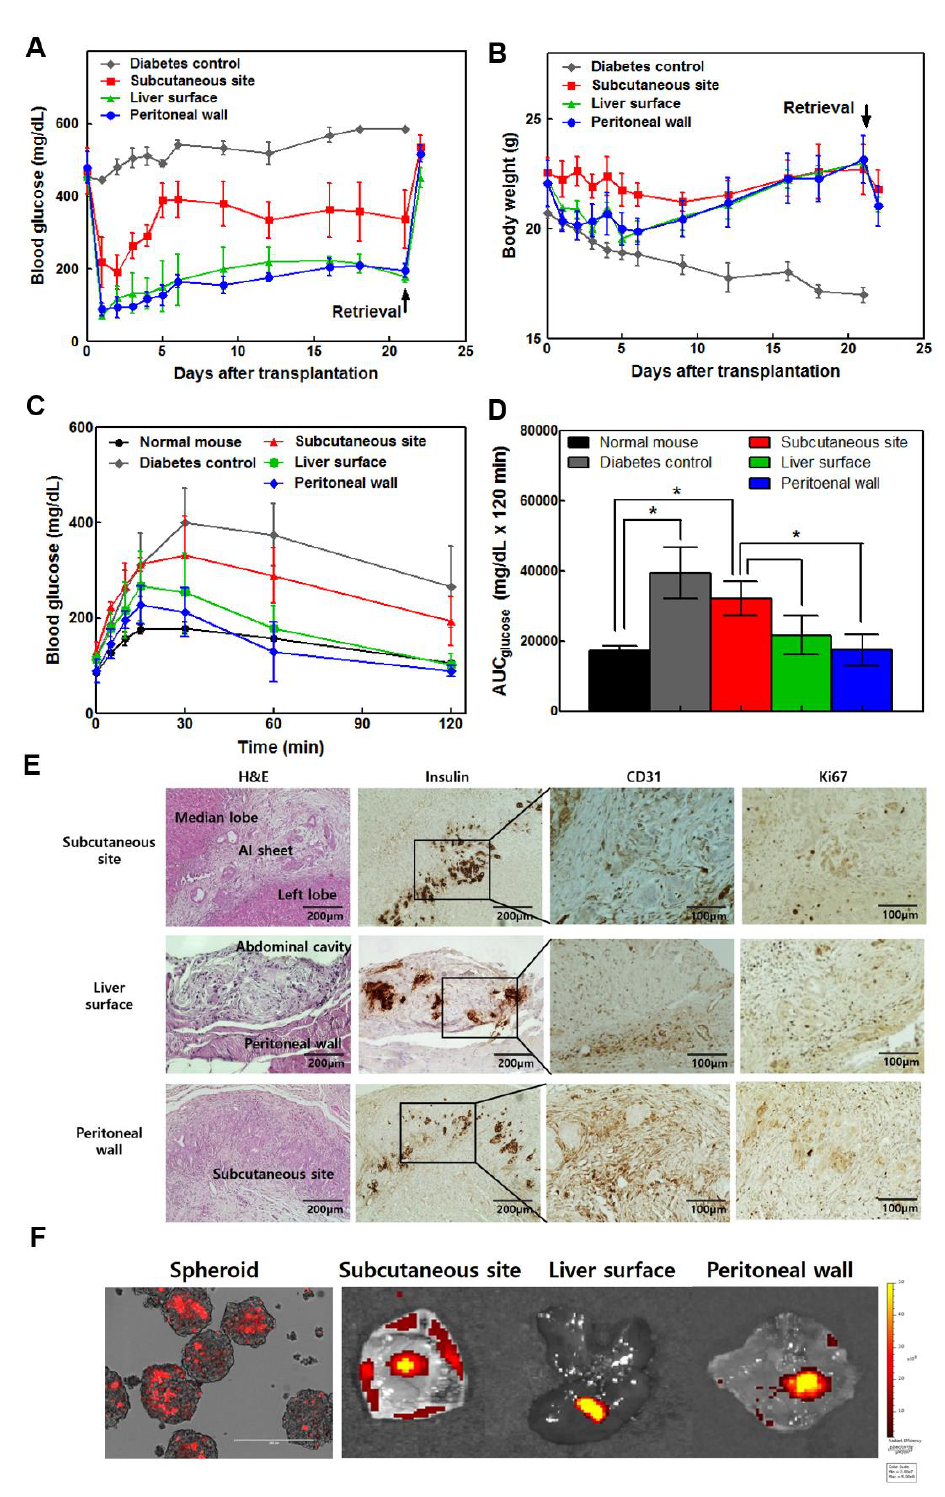
Figure 4. The liver and peritoneal surface were more effective sites for cell sheet transplantation among subcutaneous, liver surface, and peritoneal wall sites using human islets (5000 IEQ) and ADSC multi-layered sheets in diabetic nude mice ( n = 4). ( A ) Transplantation of AI sheets onto the three sites was performed successfully. The liver and peritoneal surface were more effective for controlling blood glucose levels. ( B ) The liver surface and peritoneal wall groups showed increased body weight. The subcutaneous group-maintained body weight, but diabetic control mice dramatically decreased in weight. ( C ) Intraperitoneal glucose tolerance test (IPGTT). The mice were fasted for 8 h, and then 2 g glucose/kg body weight was injected intraperitoneally. The baseline blood glucose was measured at 0, 15, 30, 60, and 120 min. The blood glucose profile ( C ) and area under the curve (AUC) ( D ) during